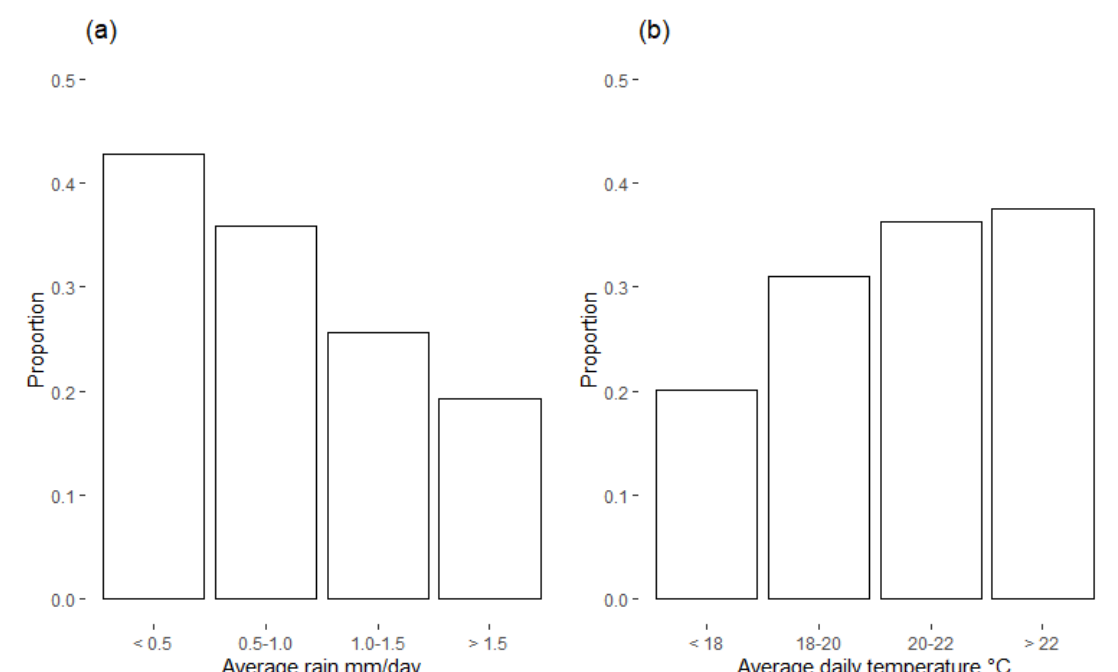
Figure 3. Proportion of samples with detectable aflatoxin (above limit of detection 0.2 µg/kg) for various levels of early rain ( a ) and late temperature ( b ). ‘Early’ refers to the first 67 days of the growing season and ‘late’ refers to the last 33 days of the maize growing season. Lower rainfall (early stage) tended to be associated with a higher proportion of aflatoxin-contaminated maize samples, while higher average daily temperatures (later stage) were associated with an increased proportion of contaminated samples. Table 3. Odds ratios and their 95% confidence intervals for parameters from the logistic regression model for the presence of aflatoxin.